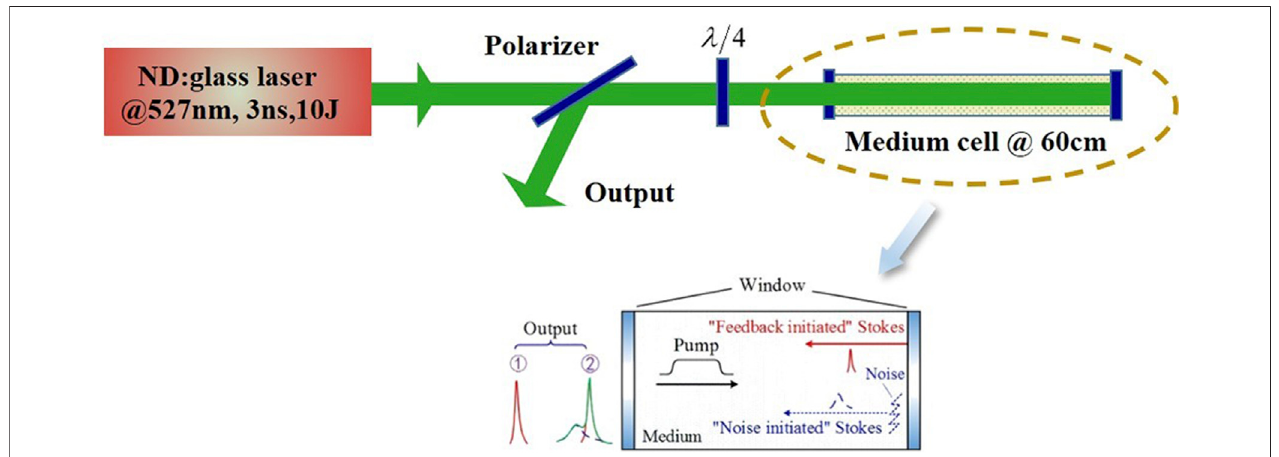
FIGURE 9 | The schematic diagram of "feedback-initiated" non-focus structure experimental device and principle: ① represents the "feedback-initiated" Stokes re fl ected pulse waveform; ② represents the coexist of "double peak" re fl ected pulse waveform of "noise-initiated" Stokes and "feedback-initiated" Stokes [109].